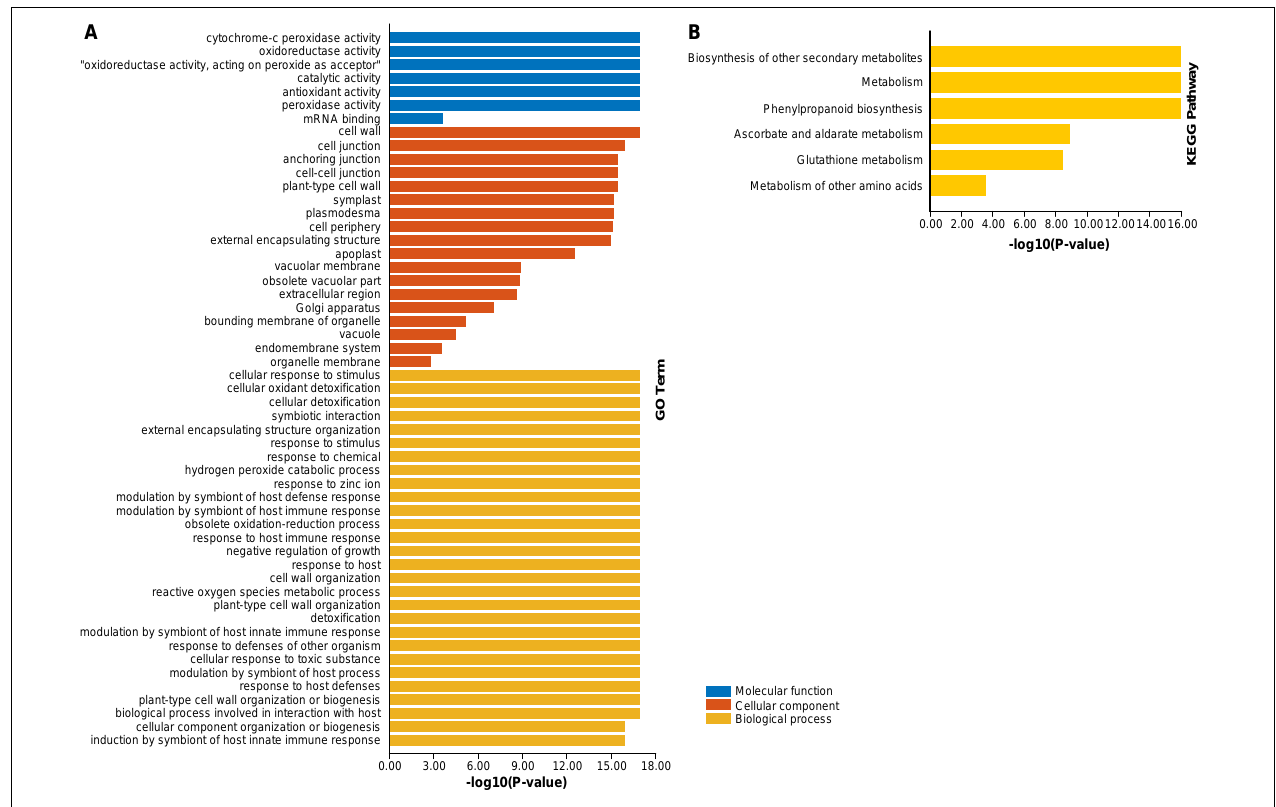
FIGURE 10 | Gene ontology (GO) and KEGG enrichment analysis of AhAPX genes. (A) The highly enriched GO terms from MF, CC, BP classifications in AhAPX genes. (B) The highly enriched KEGG pathways in AhAPX